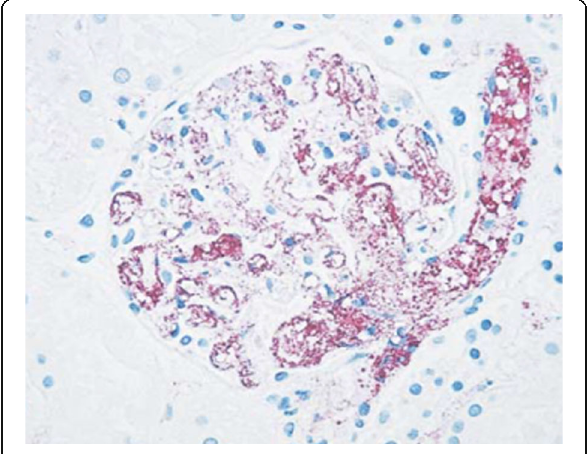
Fig. 3 Immunohistochemical stain of a kidney sample demonstrating granular antigen staining delineating the blood vessels in the glomerulus (anti fraction 1 Y. pestis antibody,